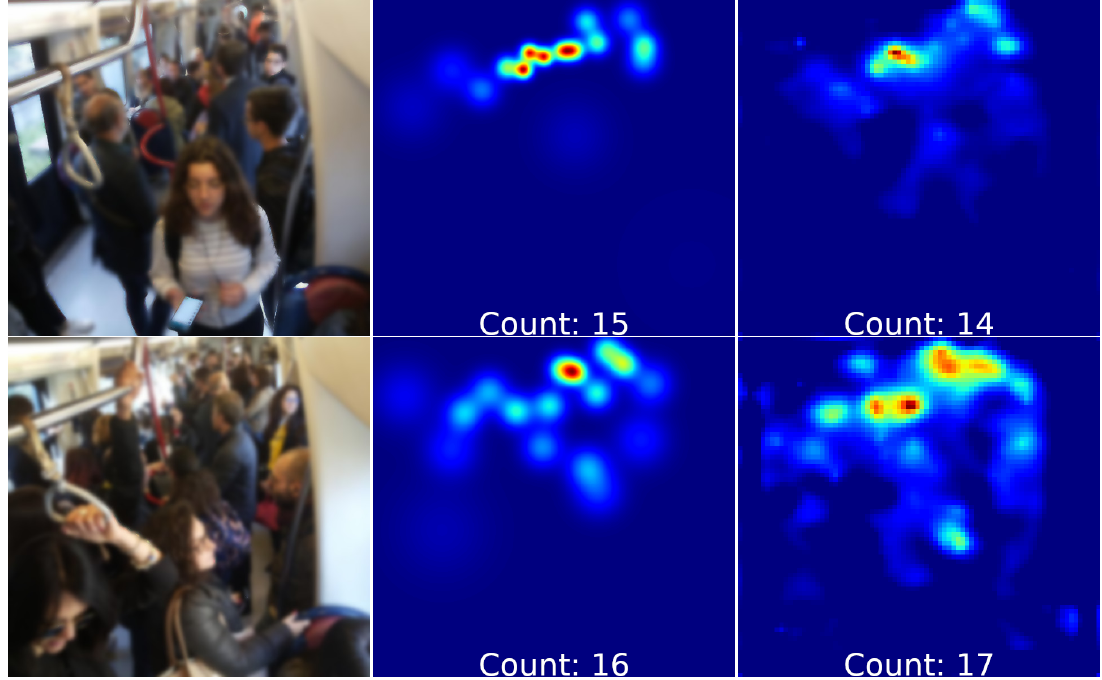
Figure 9. Subway cars dataset density map estimation examples:( Left ) the crowd image, ( center ) ground-truth density map, ( right ) estimated density map (with passengers